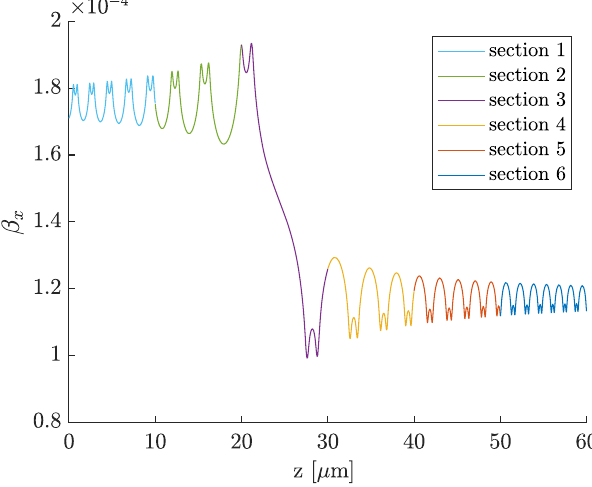
FIG. 3. Reduced velocity β x ¼ v x =c perpendicular to the plane as a function of distance traveled in the crystal, for a 12.6 GeV electron hitting the (111) plane of a bent silicon crystal with a bending radius of 0.15 m and an entry angle of 175 μ rad. Here multiple Coulomb scattering is not included. Each color repre- sents a section in which the radiation spectrum has been evaluated. The corresponding spectra are shown in Fig. 4.